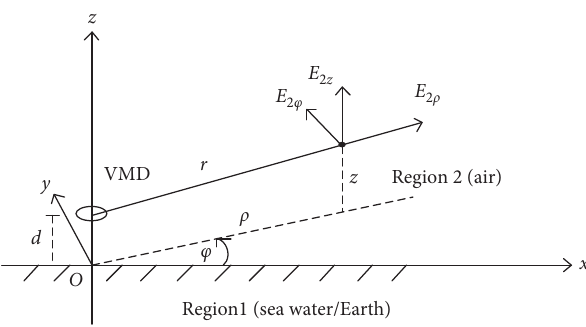
Figure 1: Excitation of an ELF/SLF VMD above a lossy